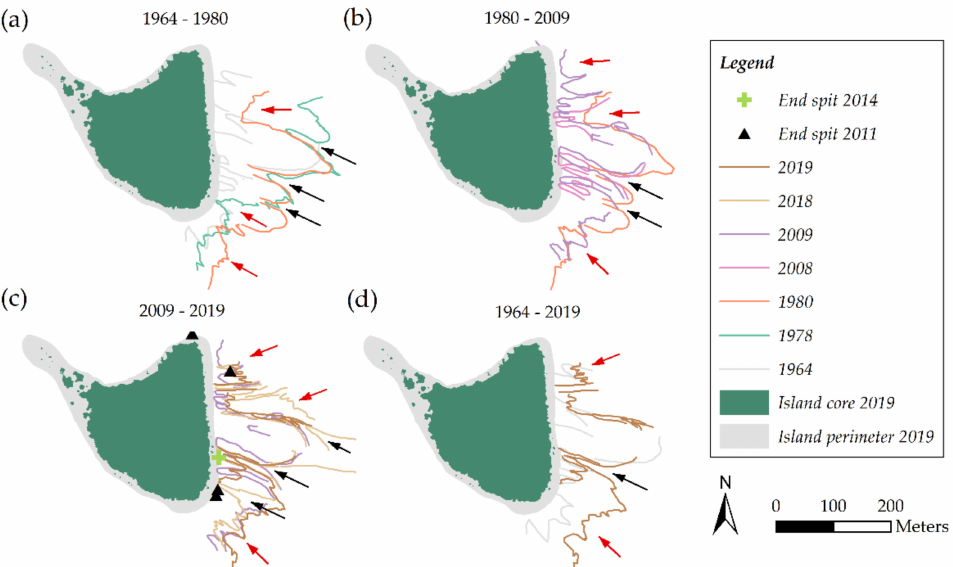
Figure 7. Presence and location of featureless rubble sheets and rubble spits in OTI from ( a ) 1964 to 1980, ( b ) 1980 to 2009, ( c ) 2009 to 2019, and ( d ) 1964 and 2019. Examples of featureless rubble and well-defined rubble spits are pointed by red and black arrows, respectively. The light green cross and the black triangle represent RTK measurements performed at the end of some rubble